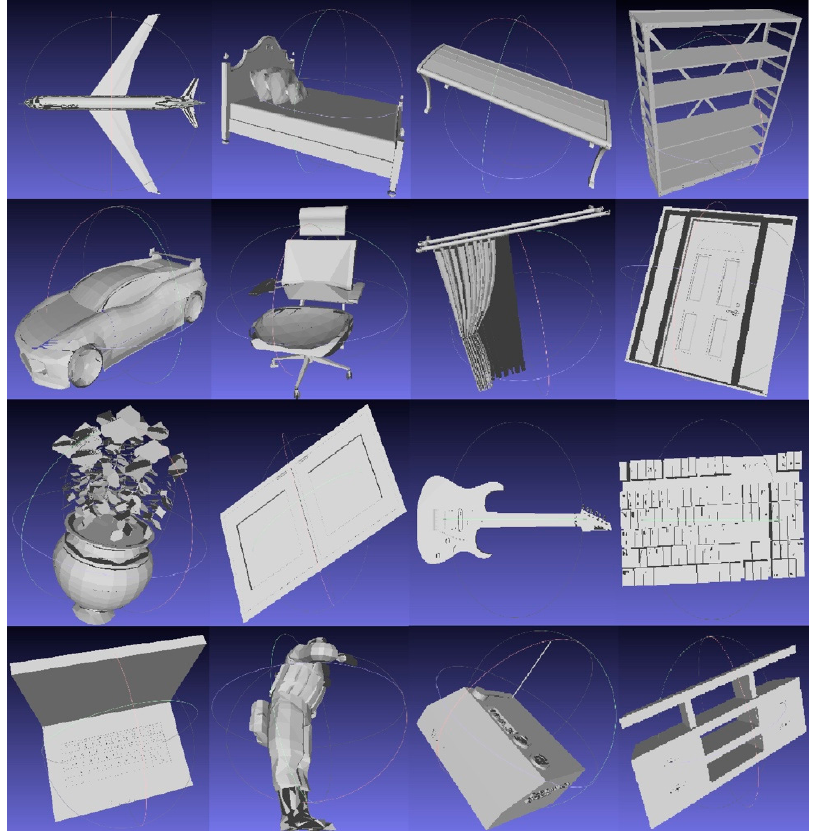
Figure 10. Random models from the re-meshing dataset: ModelNet40.